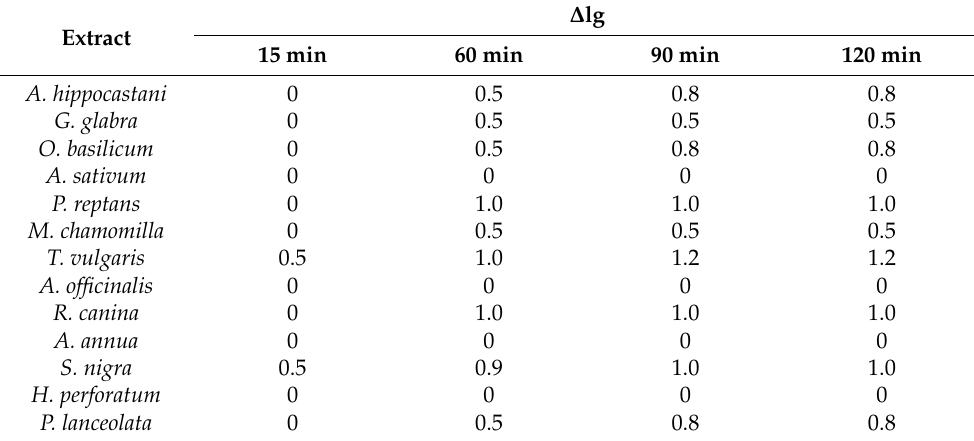
Table 3. Antiviral activity against herpes simplex virus type 1 (Victoria strain) and human coronavirus (strain OC-43).